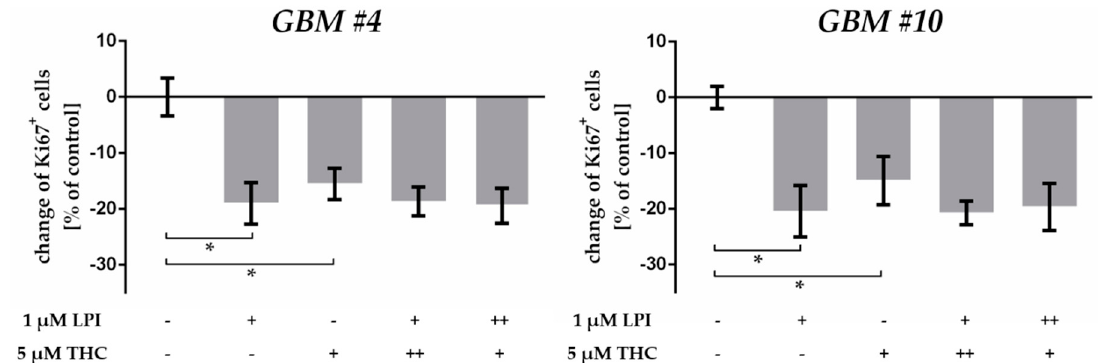
Figure 7. Co-stimulation of THC and LPI. In comparison to THC- and LPI-treated groups, co-application of LPI (1 µ M) and THC (5 µ M) caused no additive effects, regardless of the order of 15 min pre-treatment (++) with THC or LPI. Data are means ± SEM of N = 3 independent experiments performed in duplicate. Significance was chosen for p < 0.05. The asterisk denotes significant results regarding the respective measurement indicated with the